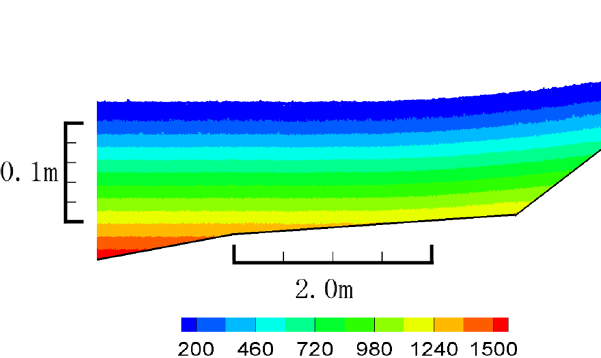
Fig. 4. Snapshot of an SPH result (case A) of solitary wave impact on the wall and pressure distribution at time instance t =